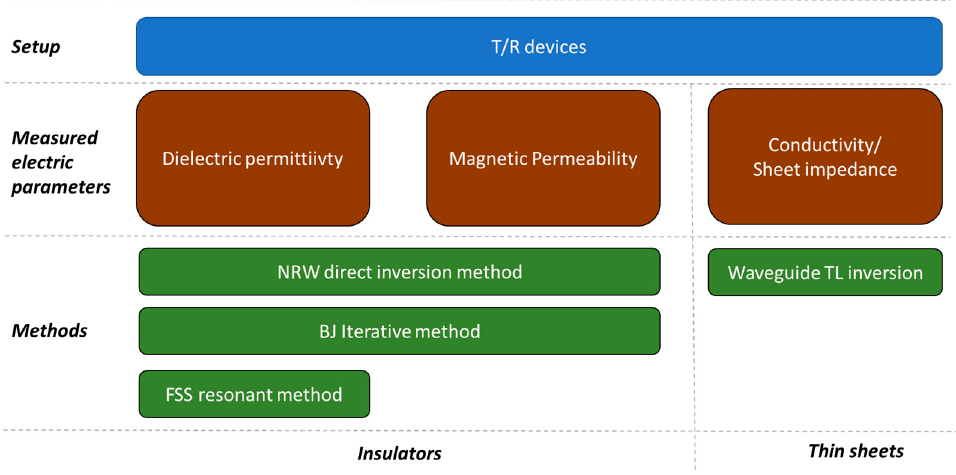
Figure 1. Classification of the T/R methods for EM characterisation of materials.